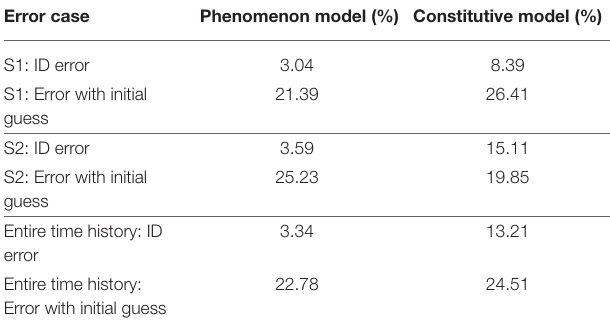
TABLE 3 | RMS error in two model updating